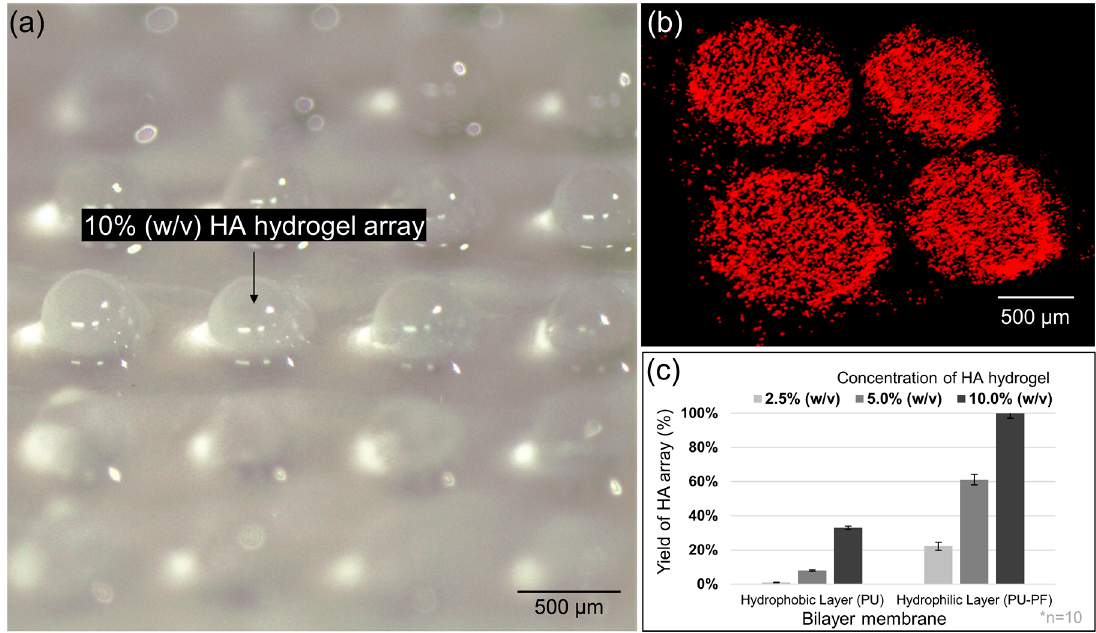
Figure 4. The results of the cross-linked HA hydrogel array. ( a ) HA hydrogel array on the hydrophilic surface of the electrospun bilayer membrane. ( b ) The images of encapsulated 10 µm fluorescent beads in the HA hydrogel array. ( c ) Comparison of yield of HA array on PU (hydrophobic) and PU-PF (hydrophilic) layers.